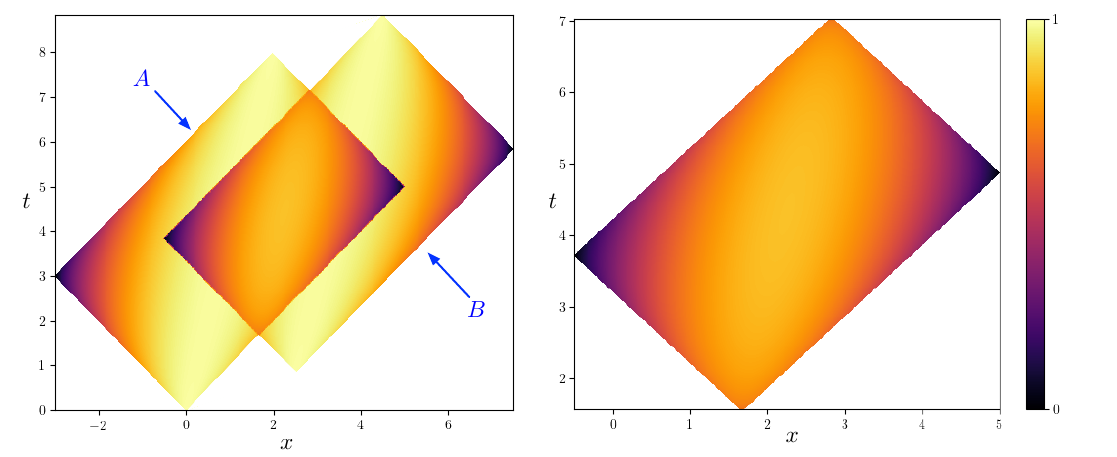
Figure 12. An illustration of the “meeting probability” of two moving objects that move on a straight line (or a road network). The right part focusses on the intersection of the two